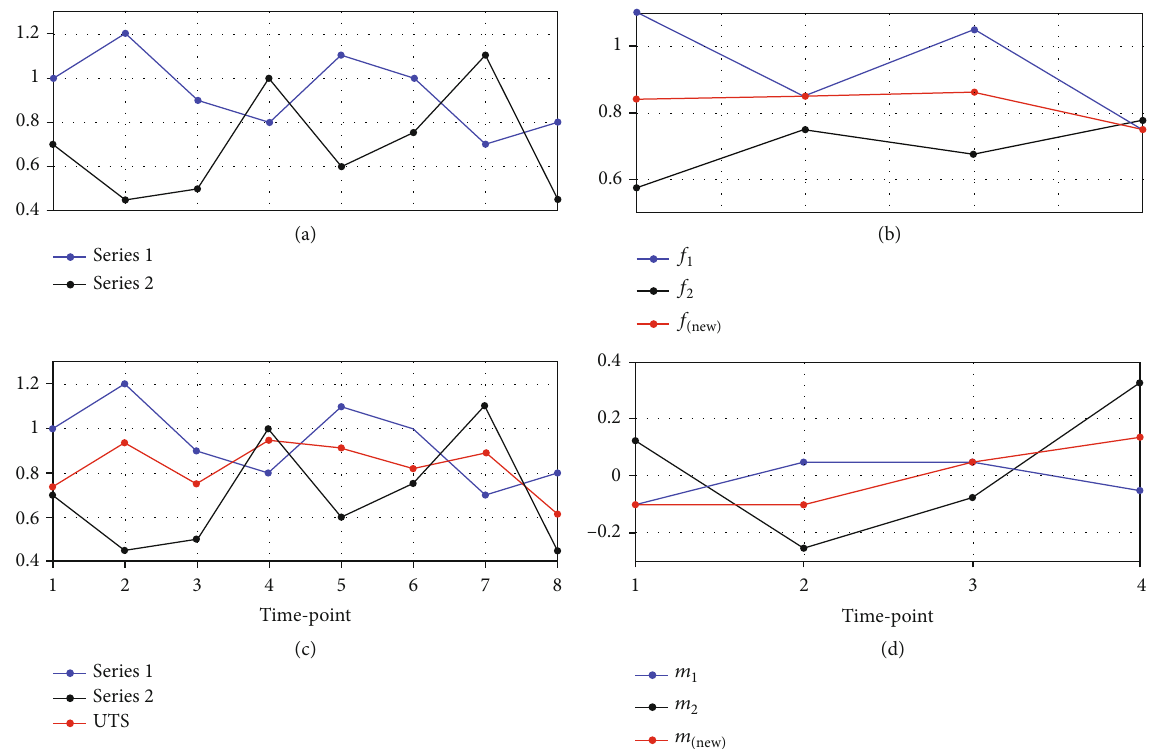
— father wavelets of and f 1 2 — new mother ð new Þ